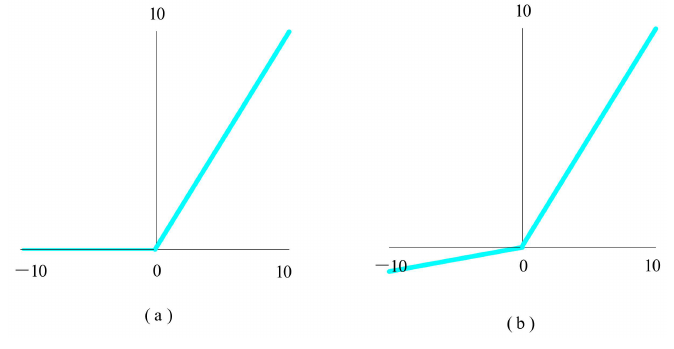
Figure 12. Functions of ReLU ( a ) and Leaky ReLU ( b ).